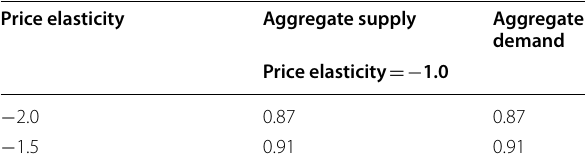
Table 7 Correlation of shocks under assumption of varying price elasticities Price elasticity